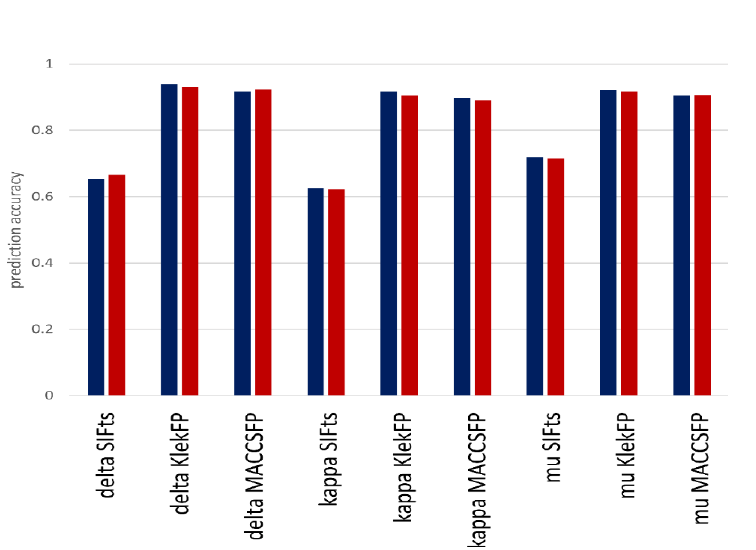
Figure 8. Prediction accuracy obtained for ML models constructed on key-based fingerprints and interaction fingerprints. Dark blue: k-nearest neighbor algorithm (IBk), red: random forest (RF).